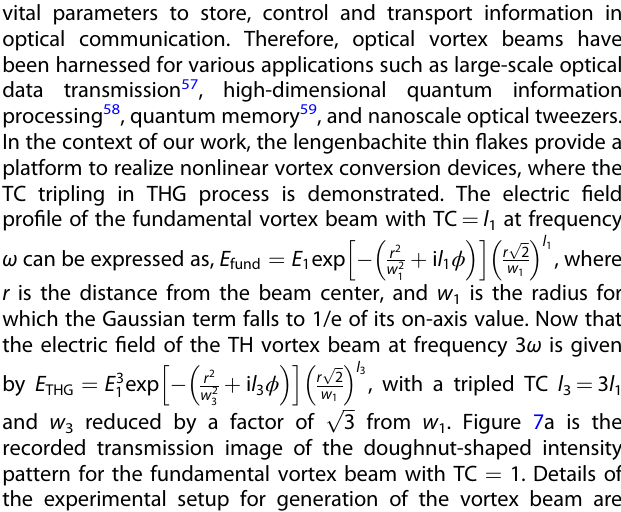
and E 2 THG fund